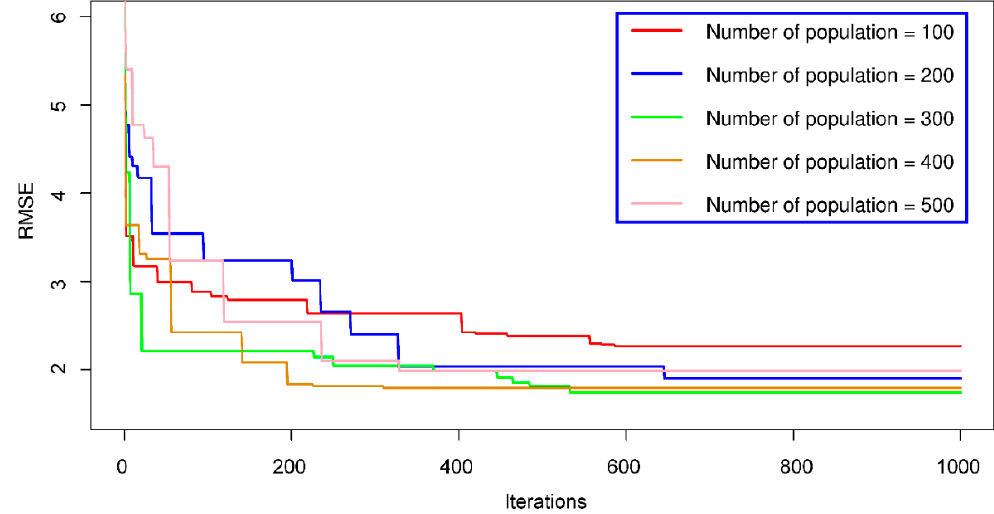
Figure 6. Genetic algorithm-artificial neural network (GA-ANN) performance for estimating HL of EEB systems.